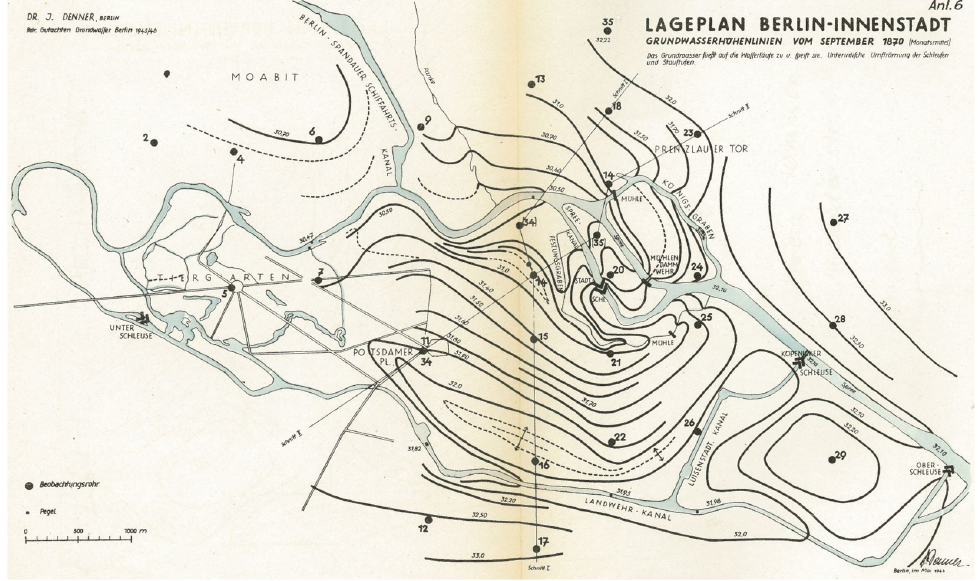
Figure 1. Map of groundwater levels in the centre of Berlin, 1870 ( adapted from Ref. [75]) (annex 6). Berlin’s groundwater monitoring network was extended over the following